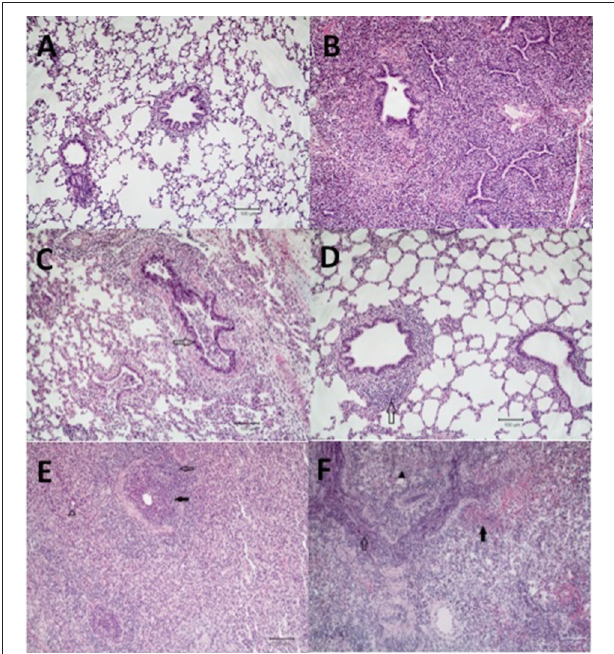
FIGURE 3 | Microscopic lung lesions from representative pigs at necropsy. Groups of pigs were inoculated with B. bronchiseptica (Bb) on day − 7, LAIV on days 0 and 21, and subsequently challenged (Ch) with heterologous IAV on day 42 as described in materials and methods. A Non-vaccinated (NV) group and a NV/non-challenged (NV/NCh) control group were included as controls. At 5 days post-infection lung sections were collected at necropsy and processed as described in materials and methods. Photomicrographs showing (A) normal lung in a non-infected control pig (NV/NCh); (B) interstitial thickening due to fibroplasia with mononuclear alveolar infiltrates in a pig chronically infected with Bb-only (Bb/NV/NCh); (C) suppurative bronchiolitis with epithelial necrosis (open arrow), characterized by loss of cilia and nuclear pyknosis, from a pig infected with IAV-only (NV/Ch); (D) peribronchiolar lymphocyte infiltration and BALT hyperplasia (open arrow) in a vaccinated pig challenged with IAV (LAIV/Ch); (E) suppurative bronchiolitis with epithelial necrosis (closed arrow), submucosal lymphohistiocytic inflammation, peribronchiolar lymphocytic infiltration (open arrow), interstitial pneumonia, and alveoli filled with neutrophils (open arrow head) demonstrating lesions of IAV infection and acute Bordetellosis in a pig that was infected with Bb and subsequently challenged with IAV (Bb/NV/Ch); and (F) alveoli and bronchioles filled with neutrophils and mononuclear cells (open arrow), alveoli with areas of epithelial necrosis and hemorrhage (closed arrow), and interstitial pneumonia (closed arrow head) demonstrating lesions of acute Bordetellosis in a vaccinated pig that had been infected with Bb and subsequently challenged with IAV (Bb/LAIV/Ch). Macropscopic pneumonia score for pig in which representative sections were selected are indicated with a red data point in Figure 2 .